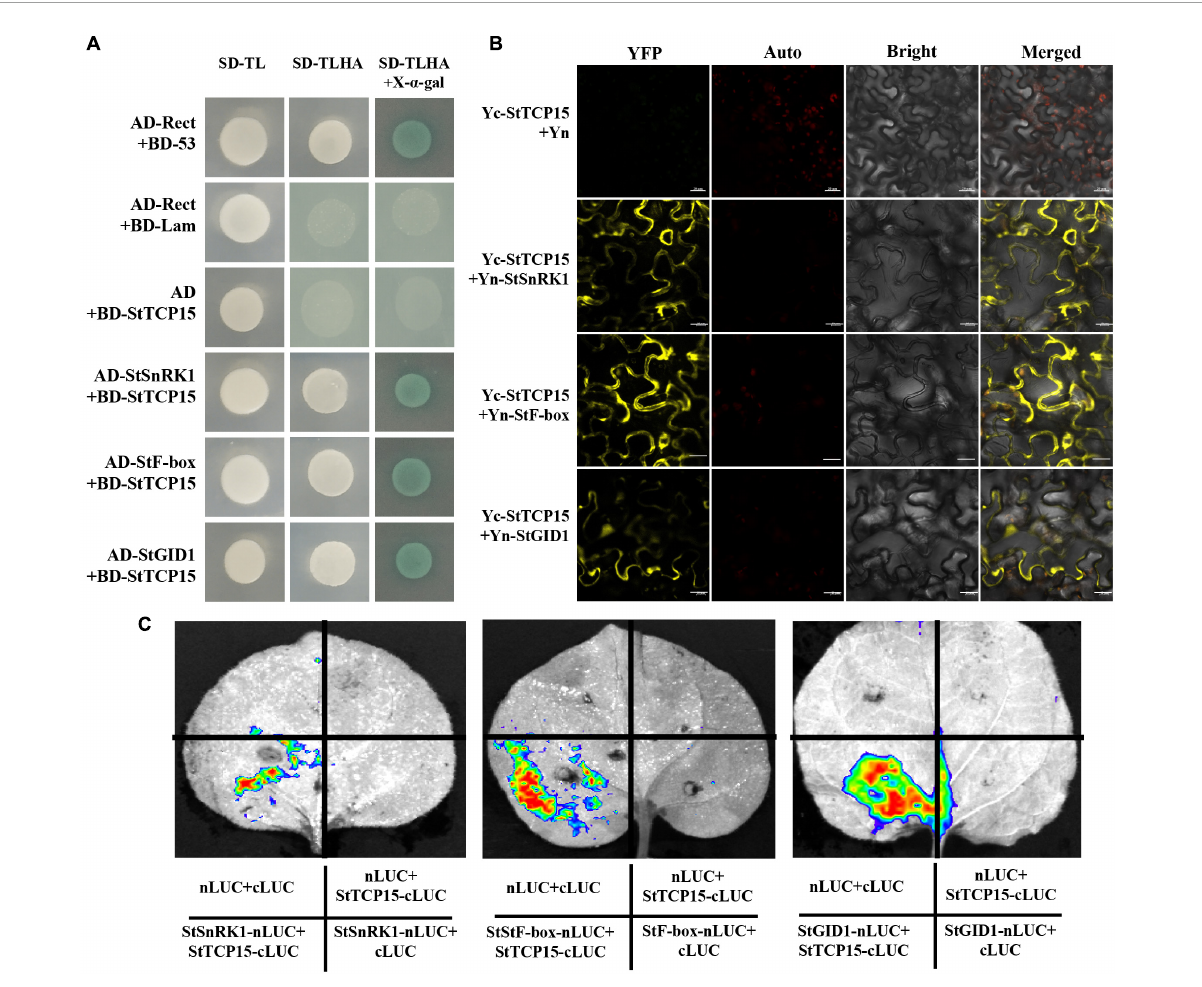
FIGURE6 (A) The Y2H reciprocal interactions between the interacting protein and the StTCP15 protein. AD, pGADT7. SD-TL stands for -Trp-Leu auxotrophic media; SD-TLHA stands for -Trp-Leu-His-Ade auxotrophic media, where x- α -gal was added to promote blue. (B) BiFC analysis was used to detect the interaction of StTCP15 in tobacco. Yc-StCTP15 + Yn-StSnRK1/StF-bos/StGID1 was used as the experimental group; Yc-StCTP15 + Yn were used as negative controls; Yellow indicates YFP fluorescence. The scale bale represents 20 µ m. (C) Split-LUC complementation assay showing that StTCP15 could interact with StSnRK1, StF-box and StGID1 in cells of Nicotiana benthamiana leaves, respectively. The LUC signals were not detected in the corresponding negative